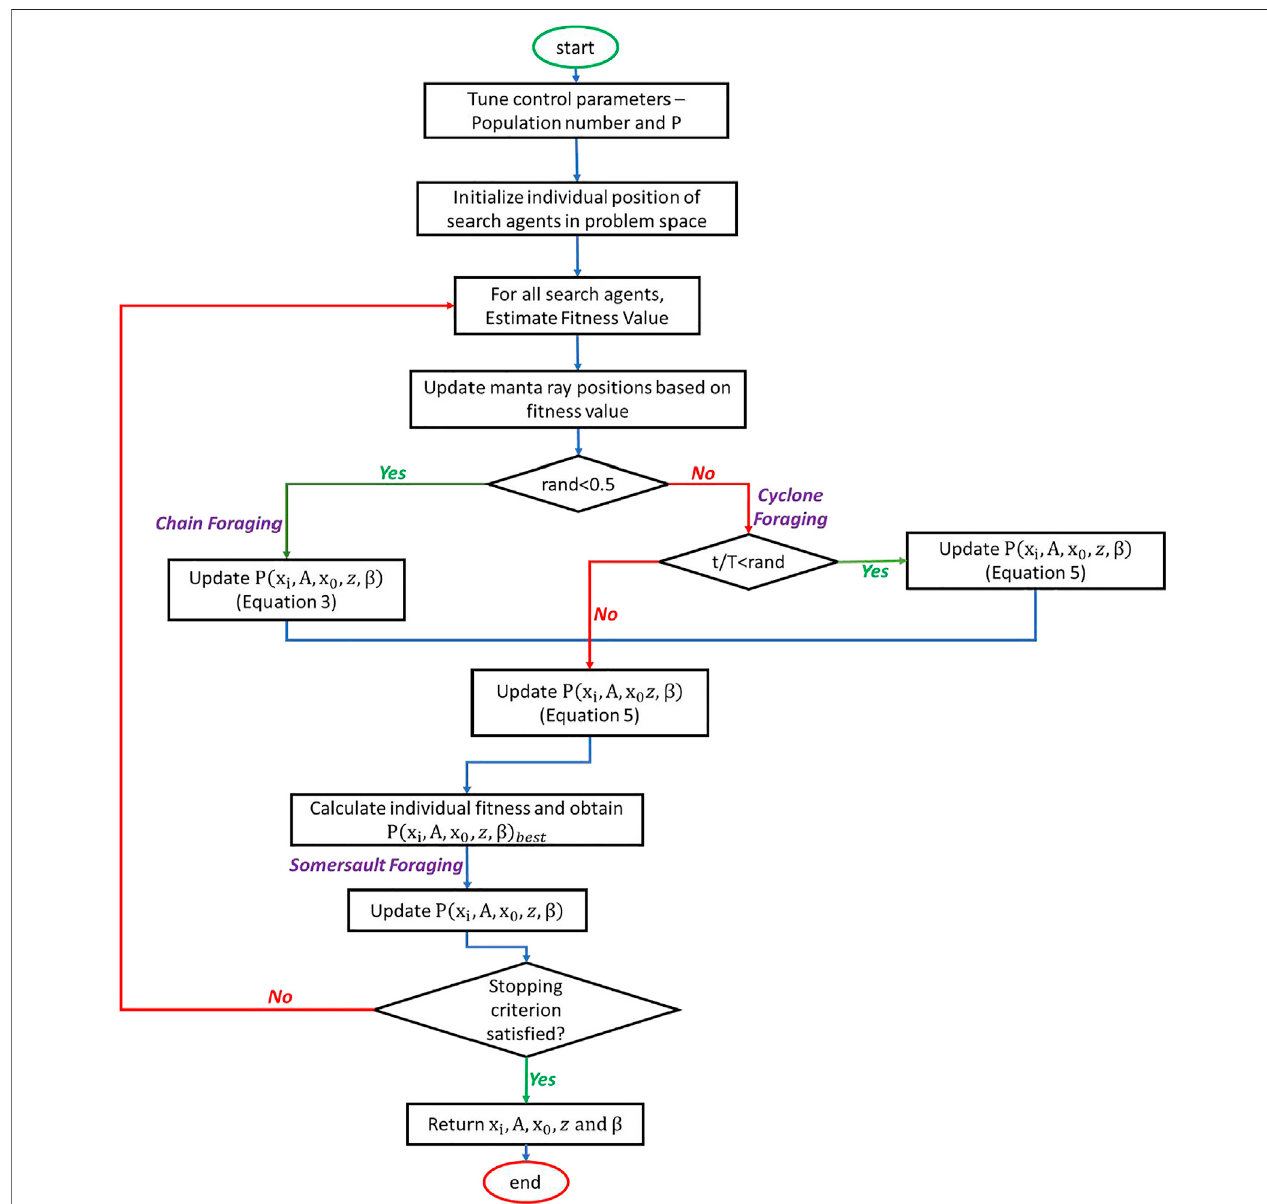
FIGURE 3 | Flowchart showing MRFO process for geophysical